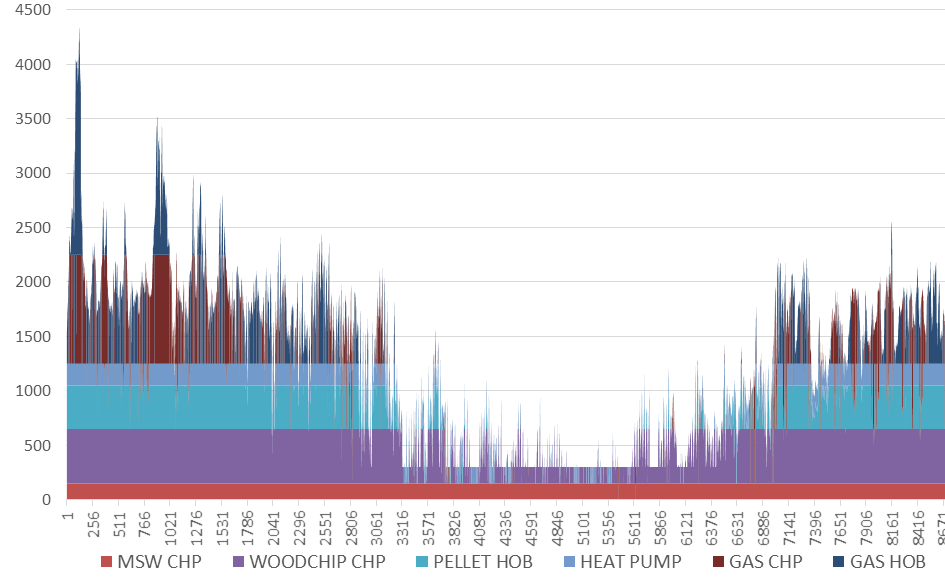
Figure 5. The modelled district heat production distribution in 2050 in MW.